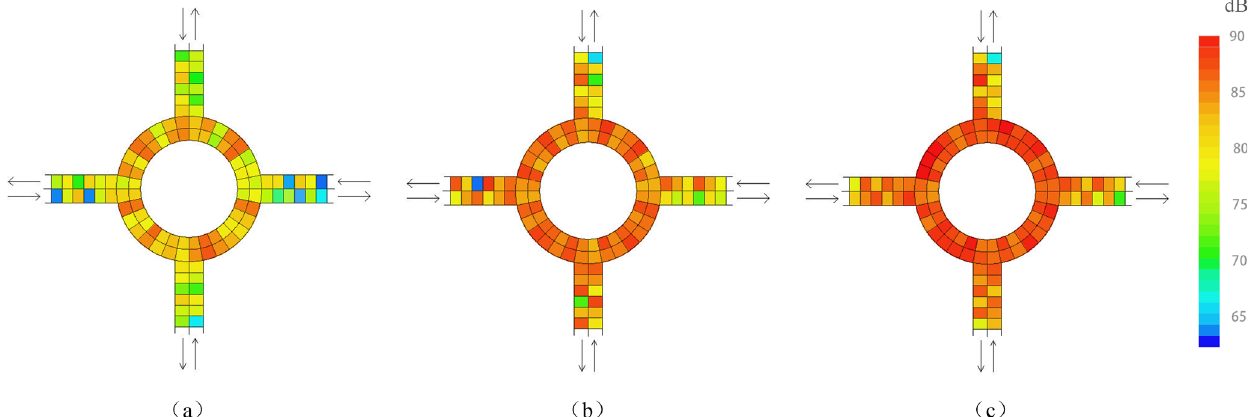
Figure 7. Hourly average sound power level distribution of cells at the roundabout obtained by simulation. (a) a = 0.01; (b) a = 0.05; (c) a = 0.1.